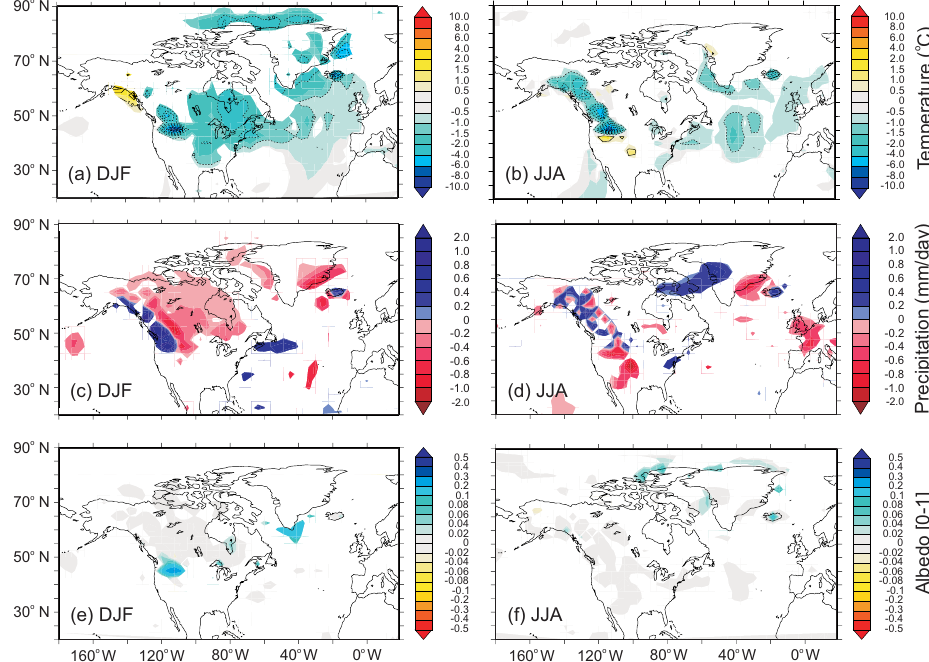
Fig. 4. Seasonal (December-January-February and June-July-August) anomalies of pre-industrial control minus “low-45N” configuration (i.e. reflecting the climate change as a consequence of mountain uplift). (a, b) surface air temperature at 2m [degrees C]; (c, d) precipita- tion [mm/day]; (e, f) surface albedo. White colouring shows regions where the interannual variability is such that there is no statistically significant change, as indicated by a Student T test with a 95% confidence threshold.